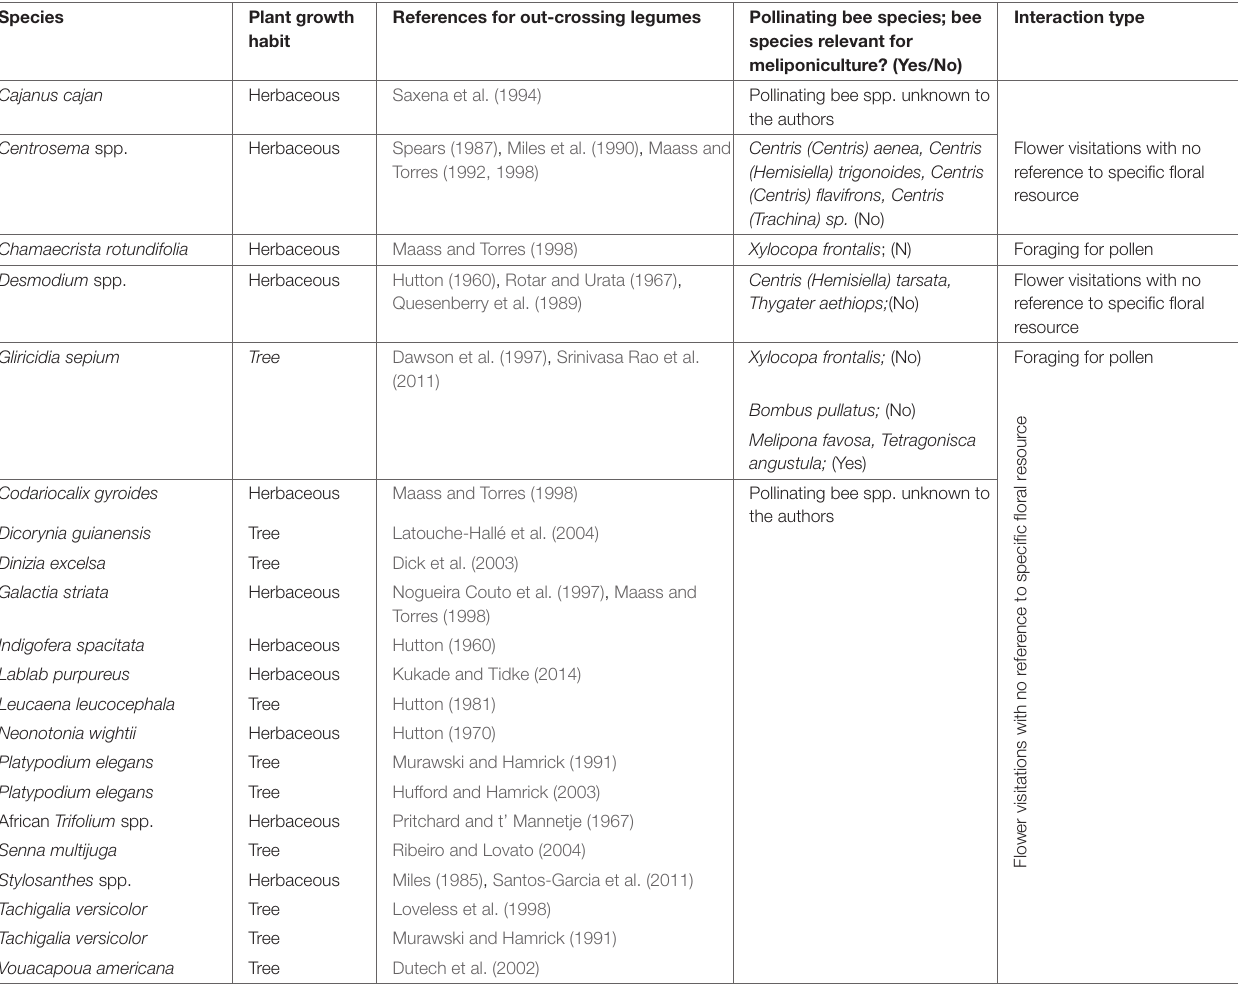
TABLE 1 | List of herbaceous and tree legumes known to be self-pollinated but with increased out-crossing when visited by different bee species.